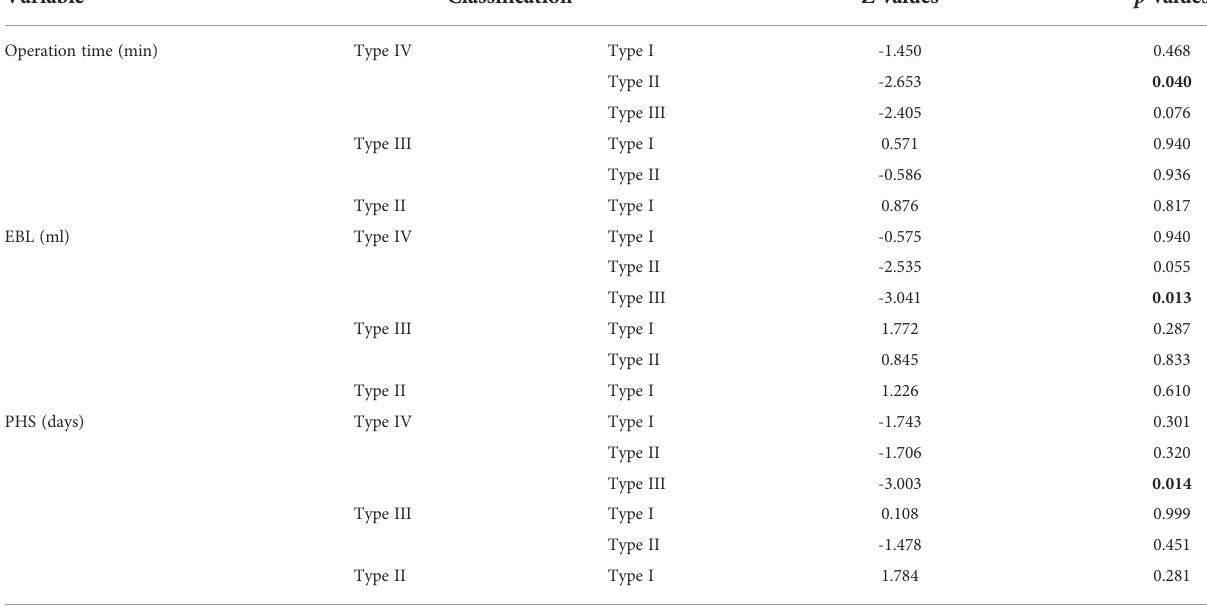
TABLE 4 In fl uence of different types on operation of patients.